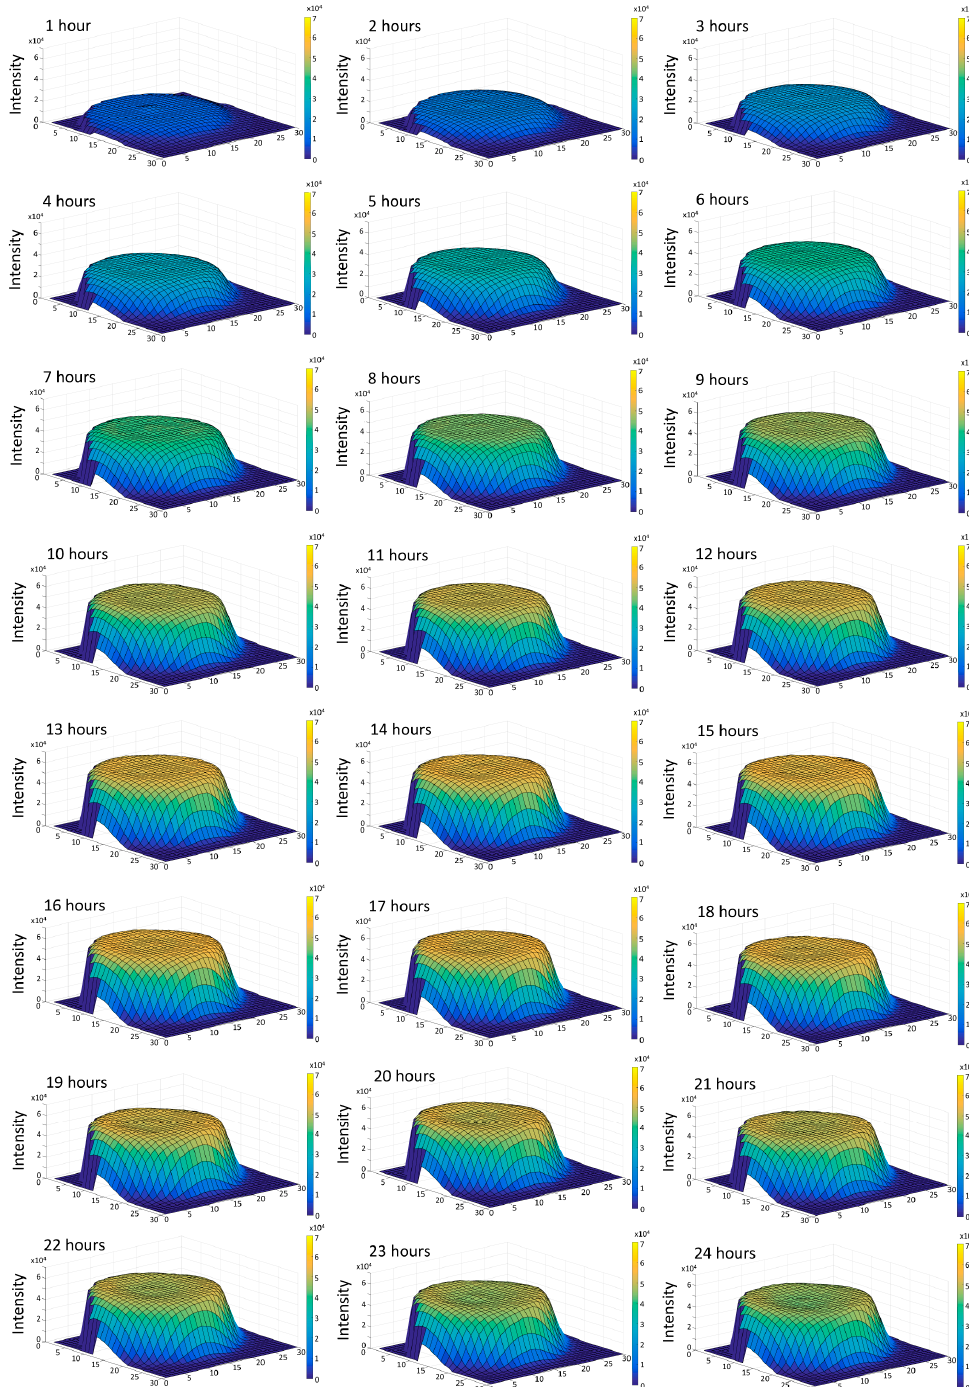
Figure 3. 3D change in fluorescence intensity of hydrogel prepared in pH 4 buffer and screened at 24 °C, every hour, over a 24 h period. every hour, over a 24 h